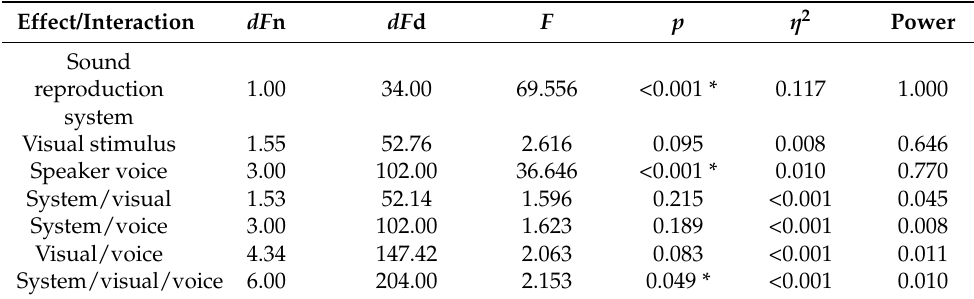
Table 3. The three-way ANOVA output table with effect size reported with η 2 and the results of the power analysis added to the rightmost